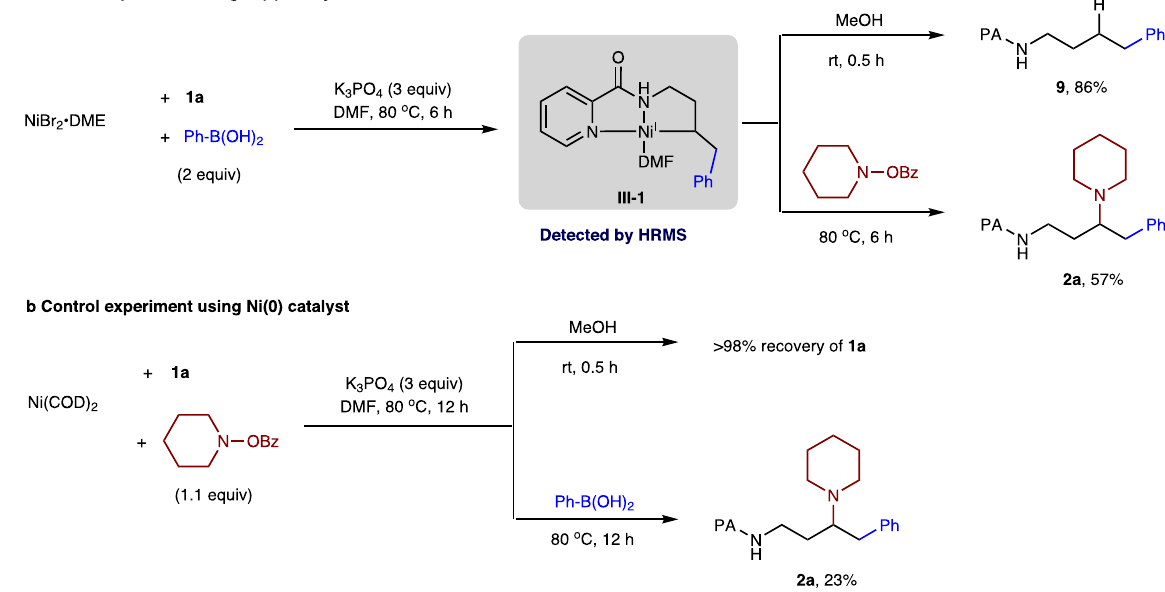
Fig. 9 Control experiments. a Control experiment using Ni(II) catalyst. b Control experiment using Ni(0) catalyst. See the Supplemental Information for detailed experimental procedures and HR-MS (high-resolution mass spectrometer) analysis. DMF